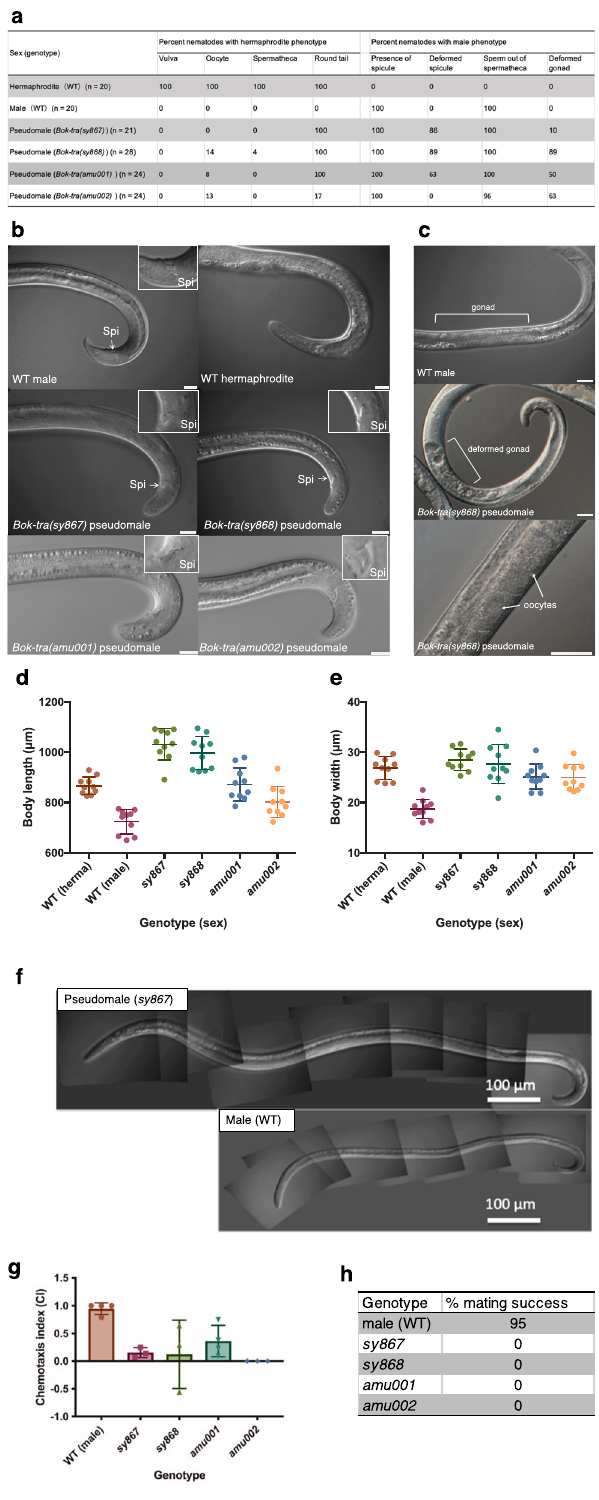
Fig. 4 Characterization of sex determination mutants in B. okinawaensis . Summary of morphological phenotype in B. okinawaensis sex-determination mutants ( a ). Phenotypes were scored by DIC microscopy. Phenotypes of the tale shapes in wild-type (WT) and mutant pseudomales ( b ). Scale bar represents 20 μ m. Spi: spicule. Phenotypes of the germline in WT male and mutant pseudomales ( c ). Scale bar represents 20 μ m. Body length ( d ) and width ( e ) in WT and mutant pseudomales. Source data are available for d , e in the Source Data File. Images of ten distinct individuals for each genotype and sex were obtained by DIC microscopy and measured using ImageJ (ver. 1.53). Data are presented as mean values ± standard deviation. Whole-body of WT male and pseudomale of Bok-tra(sy867) ( f ). Chemotaxis on WT male and pseudomales in B. okinawaensis to the chemical cue of virgin females of B. xylophilus ( g ; source data are available in the Source Data File). The assay was performed according to Shinya et al. 78 Chemotaxis index (CI) = ([number of nematodes at the test cue zone] − [number of nematodes at the control zone])/([number of nematodes at the test cue zone] + [number of nematodes at the control zone]). Chemotaxis assays were repeated four times for Bok-tra(amu001) and WT, and three times for others. Data are presented as mean values ± standard deviation. Percentages of mating success in WT male and pseudomales in B. okinawaensis with sperm-depleted old hermaphrodite of B. okinawaensis SH1 strain ( h ). Mating plates were prepared by placing a single young adult male of each genotype with two sperm-depleted old hermaphrodites on 1/10 MEA-chloramphenicol plates with yeast lawns. These plates were incubated at 25 °C; 48 h later, the number of progeny produced was counted. For each genotype, 20 biological replicates were